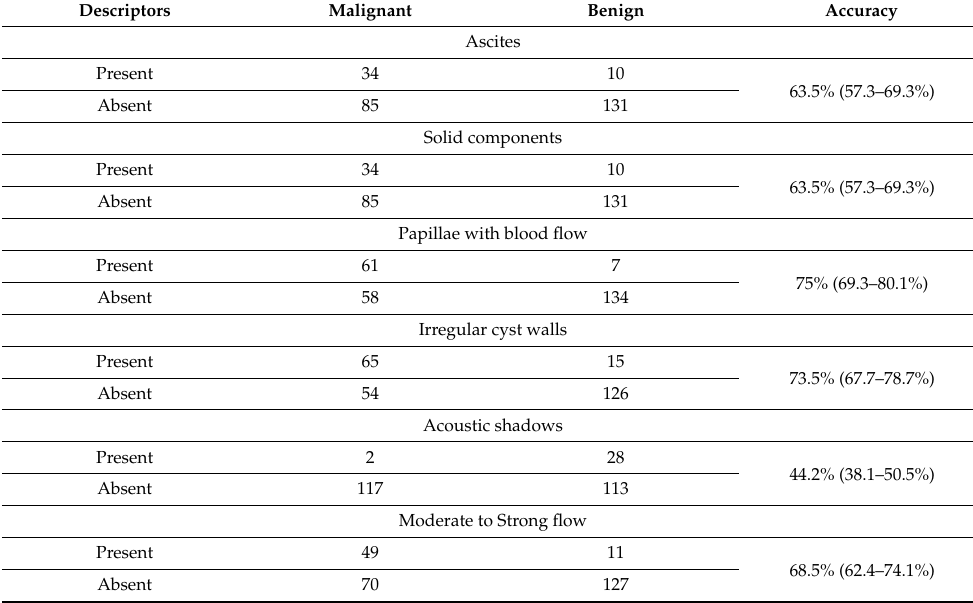
Table 2. The presence of papillae with blood flow and irregular cyst walls during the ultrasound.